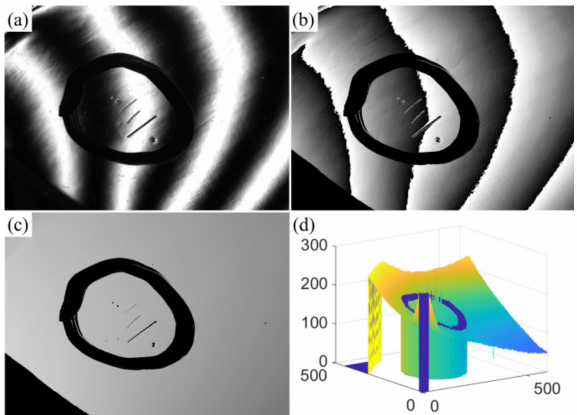
Figure 8. The process of obtaining absolute phase diagram in x direction. ( a ) Sinusoidal fringe, ( b ) wrapped phase, ( c ) absolute phase and its 3D view ( d